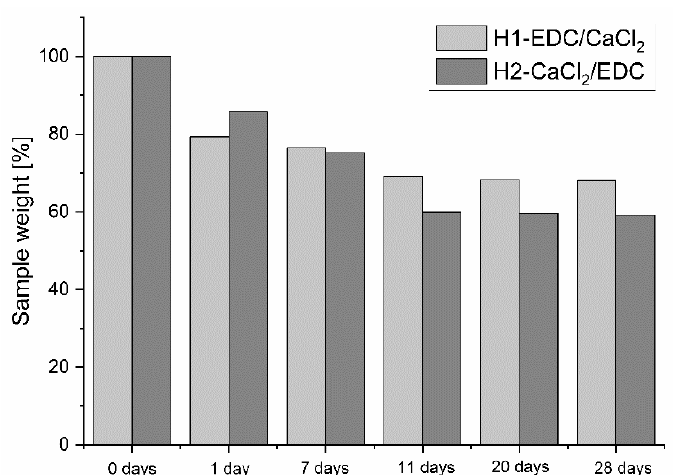
Figure 7. Results of the degradation studies for H1-DEC/CaCl 2 and H2-CCl 2 /EDC in SBF at 37 °C.